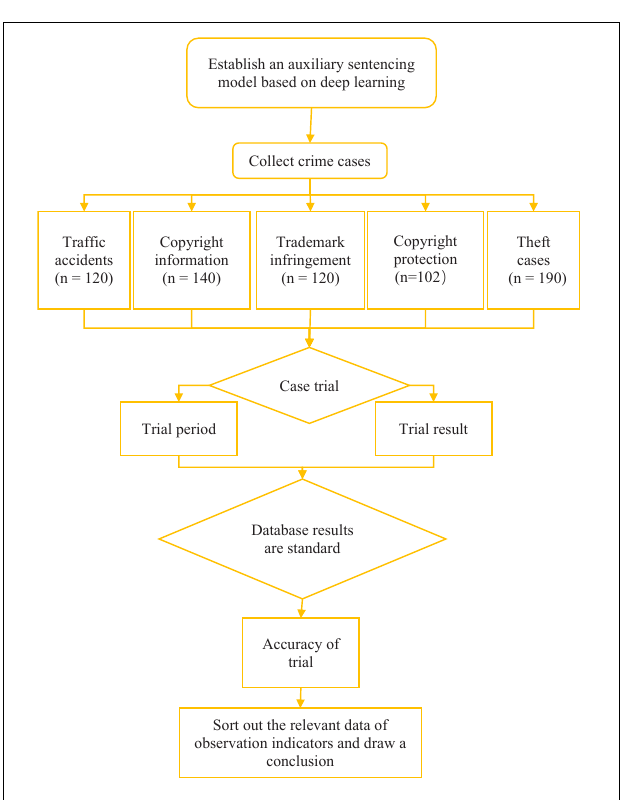
FIGURE 12 | Schematic diagram of the research